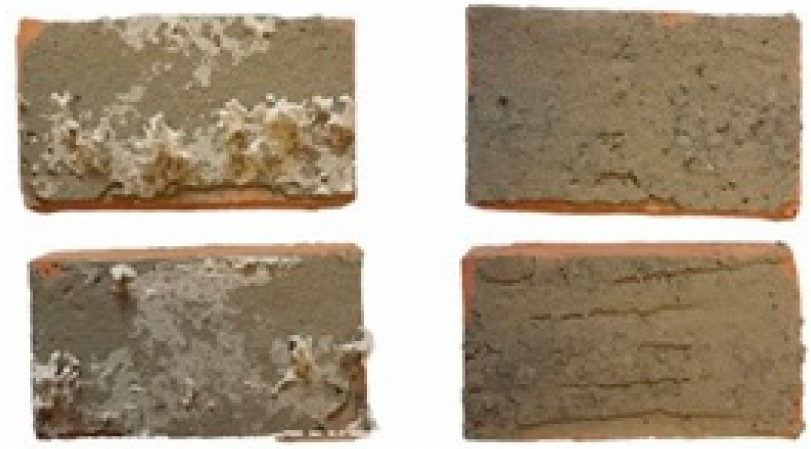
Figure 6. Surfaces of cement mortar glued to EPS (left—white, right—grey).